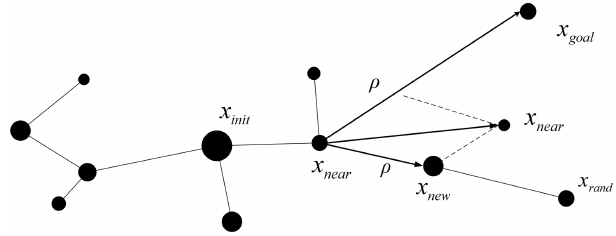
Figure 5. Extension map of RRT algorithm with added gravity component.